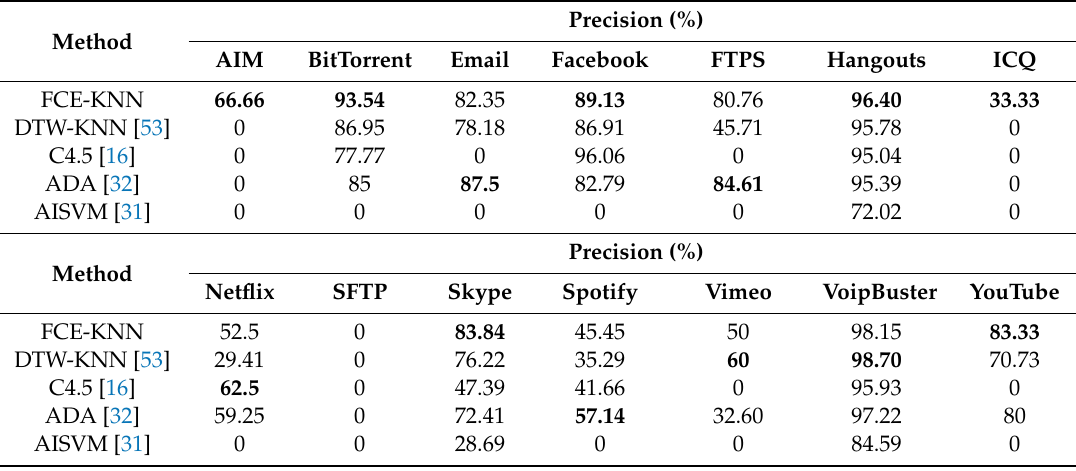
Table 5. Precision comparison between FCE-KNN and other algorithms for identifying application type of encrypted network